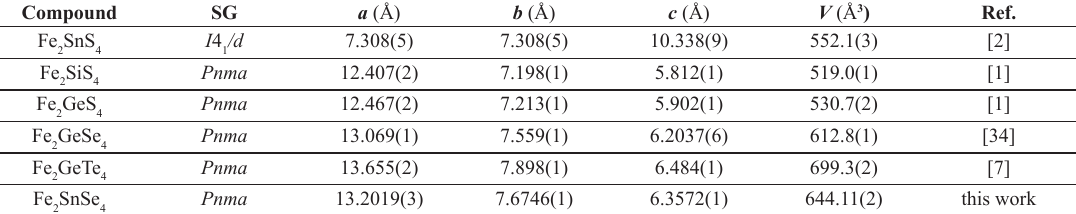
Table 3. Crystallographic information reported in the literature for the system Fe